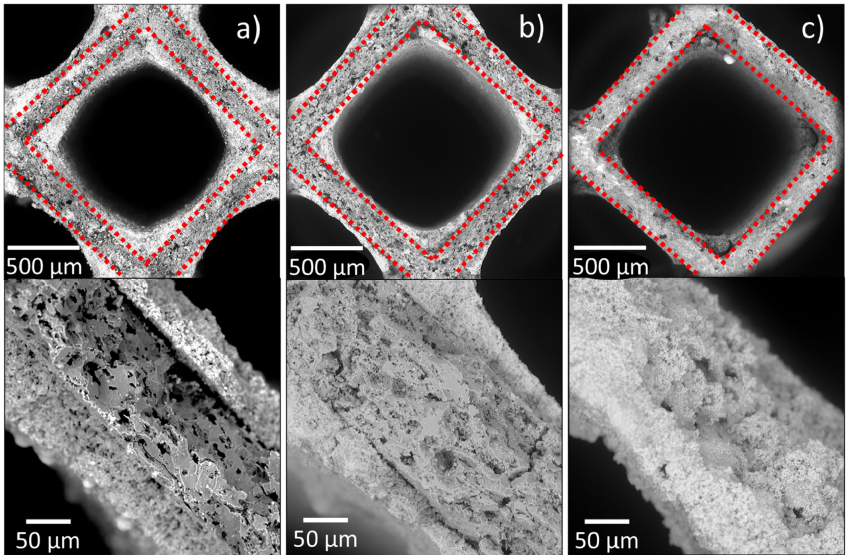
Figure 6. SEM images at different magnifications from ( a ) brand-new TWC, ( b ) moderately used TWC, ( c ) highly used TWC. Red dashed line separates the internal monolith and the external catalytic layer. The loss of the outer catalytic layer is proportional to the use.